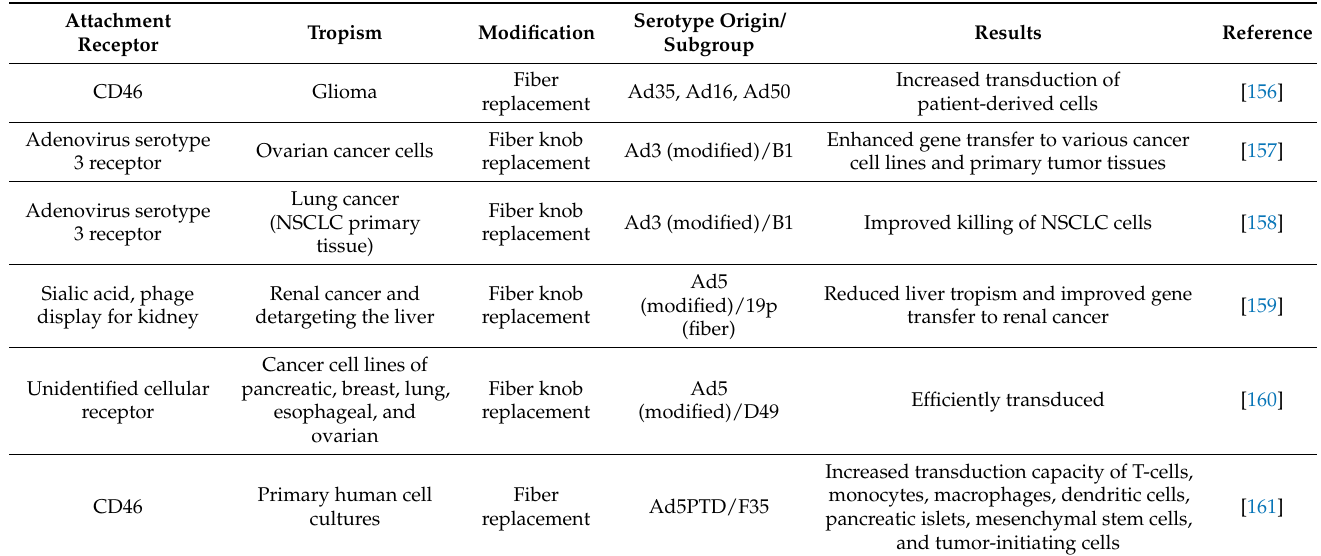
Table 3. Different studies using adenovirus pseudotyping